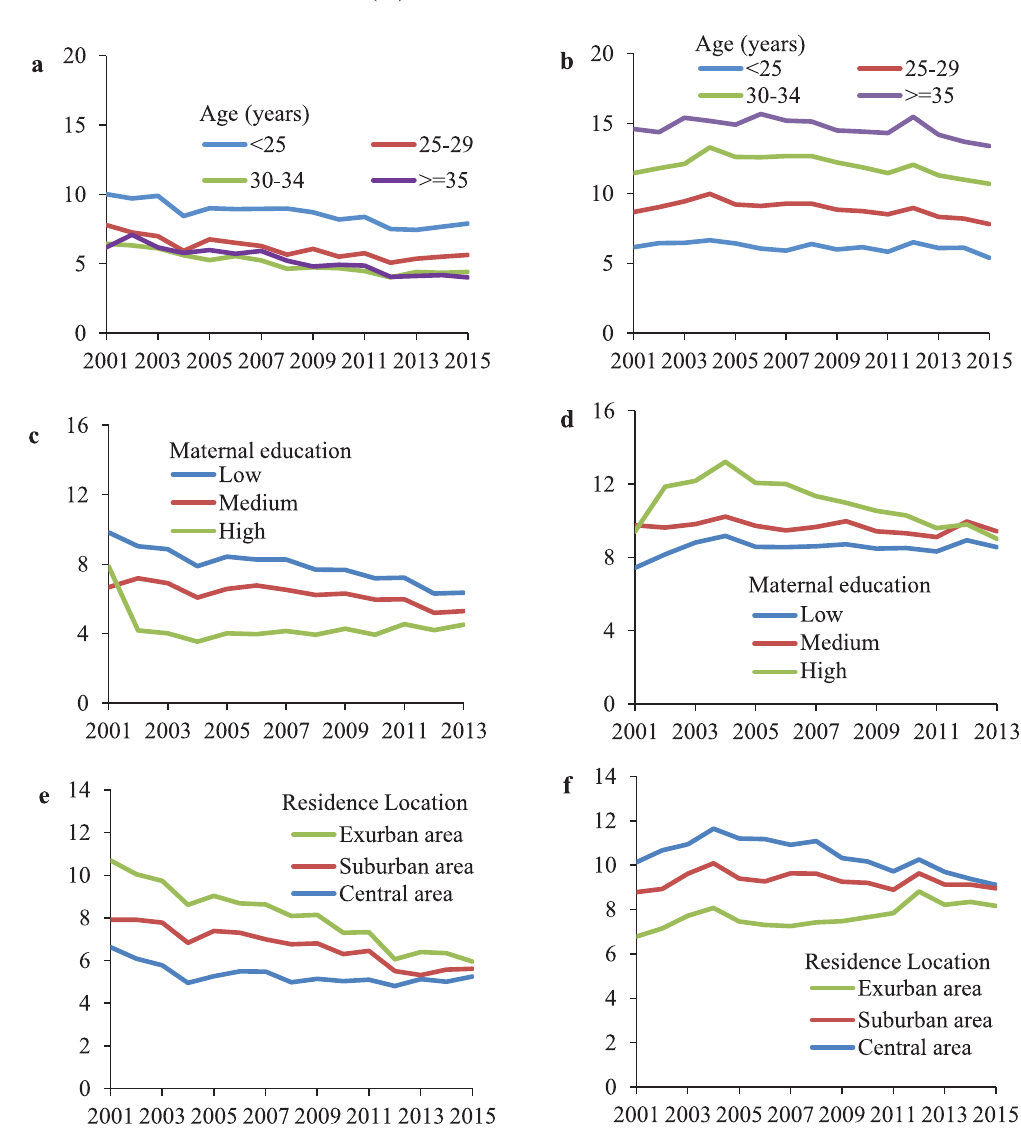
Figure 1. Changes in the incidence of SGA (left panel) and LGA (right panel) based on maternal age group ( a , b ), education level ( c , d ), and residence location ( e , f ) during 2001–2015. SGA, small for gestational age; LGA, large for gestational